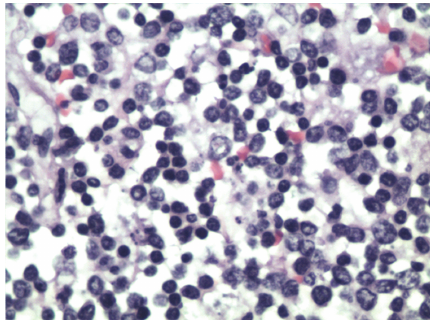
Figure 5: Immunohistochemical staining revealing BCL-2 positiv-